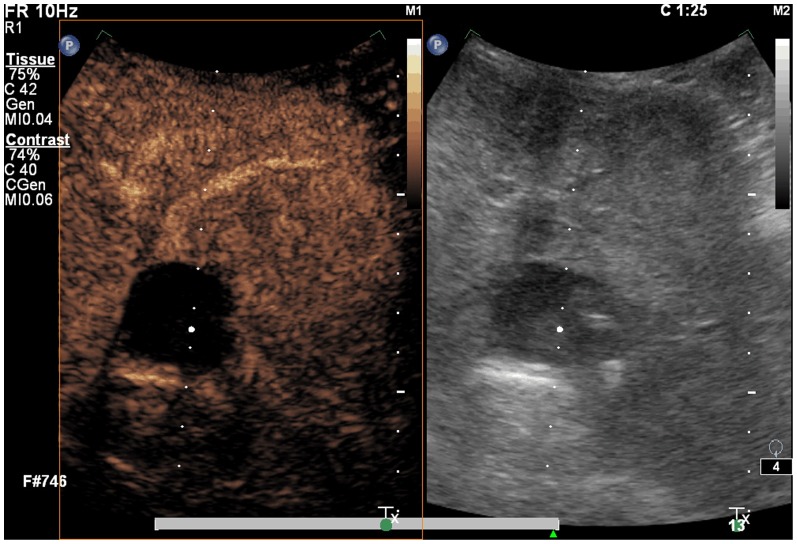
A spherical lesion with no blood flow.One year after treatment, the volume of the spherical lesion decreased mildly, but with no reinforcement of its blood flow. No blood flow was shown in the tissue surrounding the resection area.